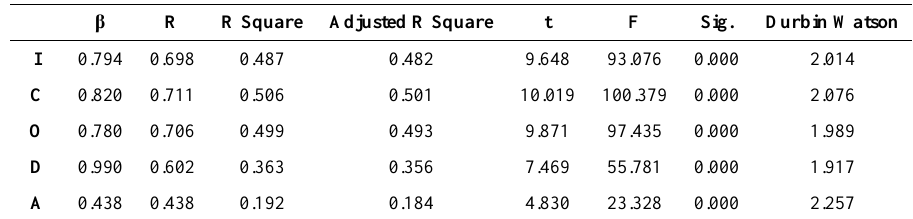
Table 8. OLS model for the public